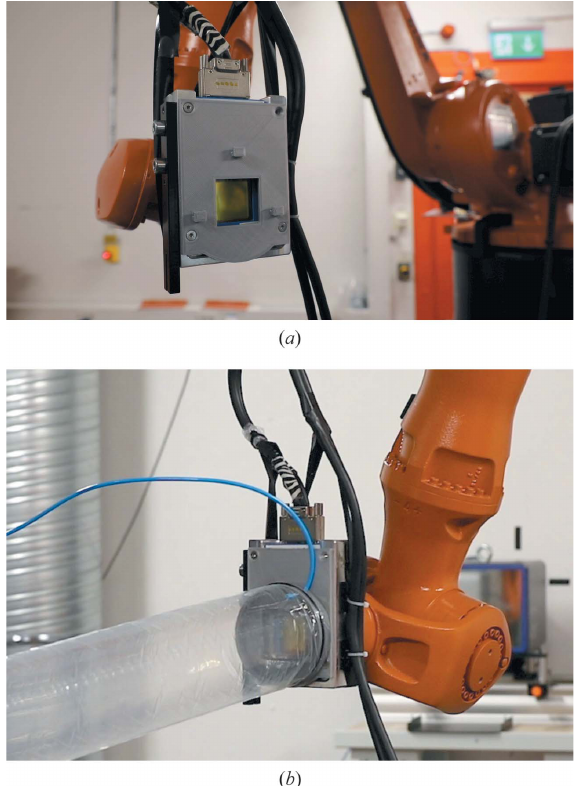
Figure 13 Photographs of the Merlin pixel detector mounted on the robot arm. ( a ) Using the three hooks visible around the central chip, ( b ) the light He- flushed flight tube is mounted on a plastic frame directly on the detector. It is positioned between the sample and the detector to reduce air scattering.